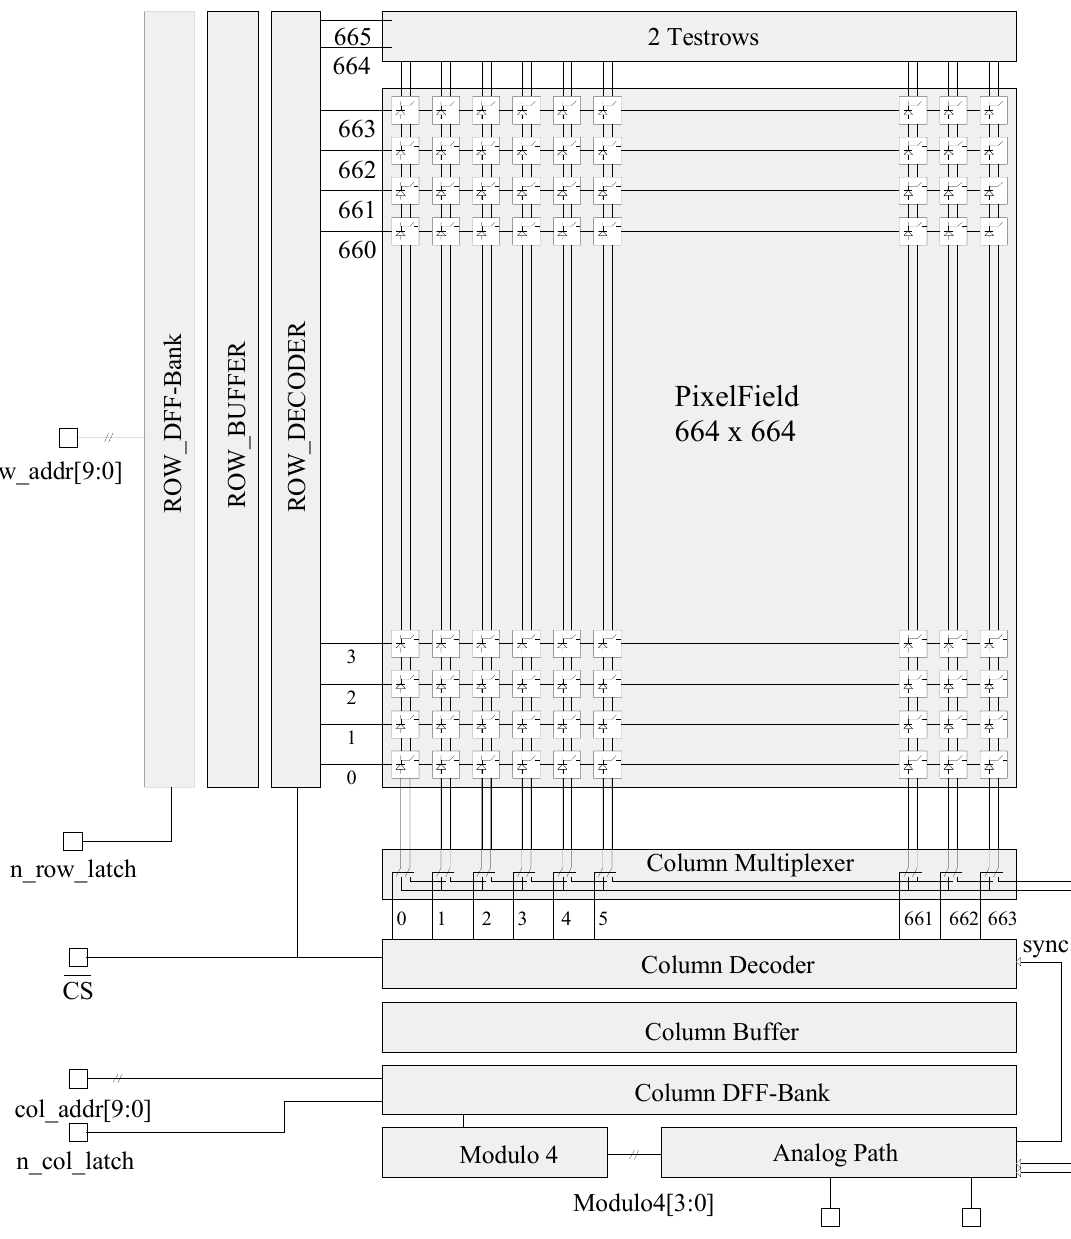
Figure 3. Schematic Architecture of the APS